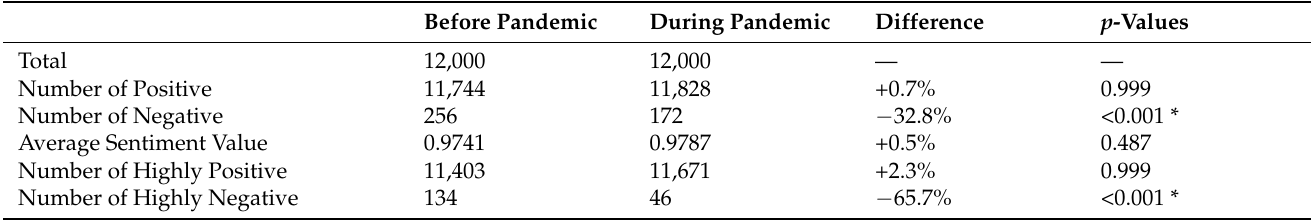
Table 2. The Numbers of Comments with Different Sentiments (Shanghai).